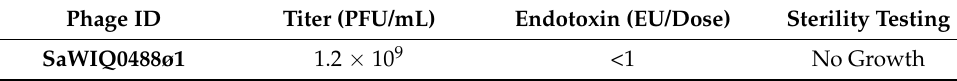
Table 1. Sterility, titers and endotoxin levels of bacteriophage used in this case. Phage ID Titer (PFU/mL) Endotoxin (EU/Dose) Sterility Testing SaWIQ0488ø1 1.2 × 10 9 <1 No